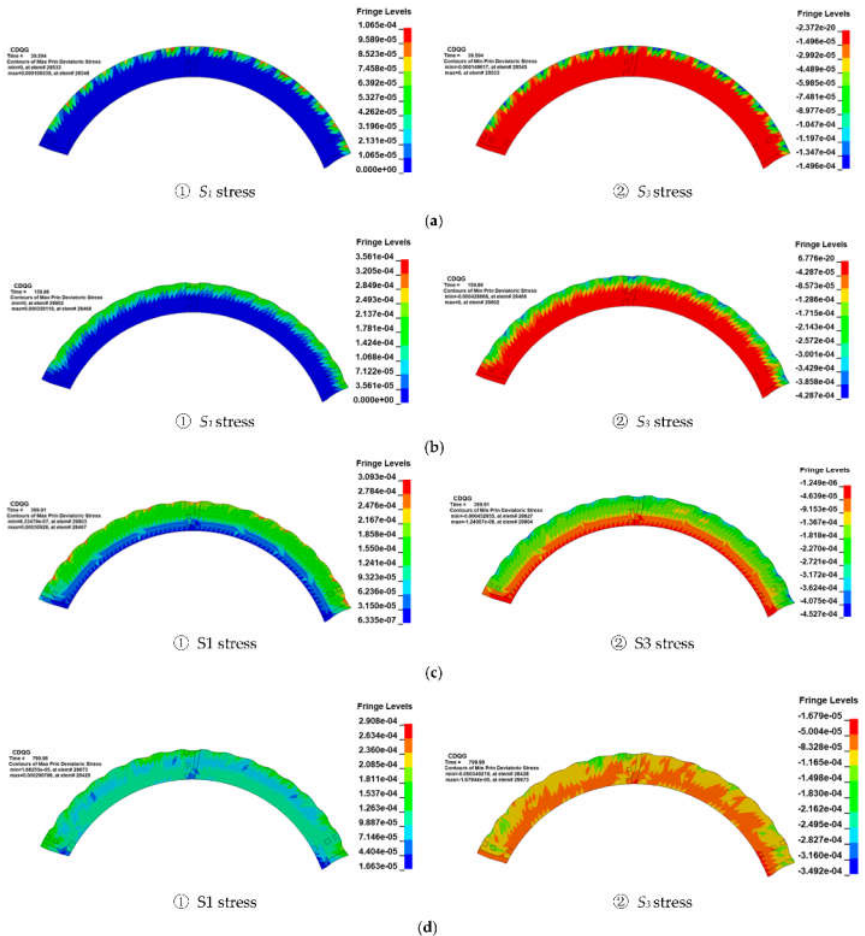
Figure 7. Principal stress nephogram at different times after blasting (unit:10 11 Pa): ( a ) principal stress nephogram at time of 0.4 × 10 − 4 s; ( b ) principal stress nephogram at time of 0.16 × 10 − 3 s; ( c ) principal stress nephogram at time of 0.4 × 10 − 3 s; ( d ) principal stress nephogram at time of 0.8 × 10 − 3 s. (1)